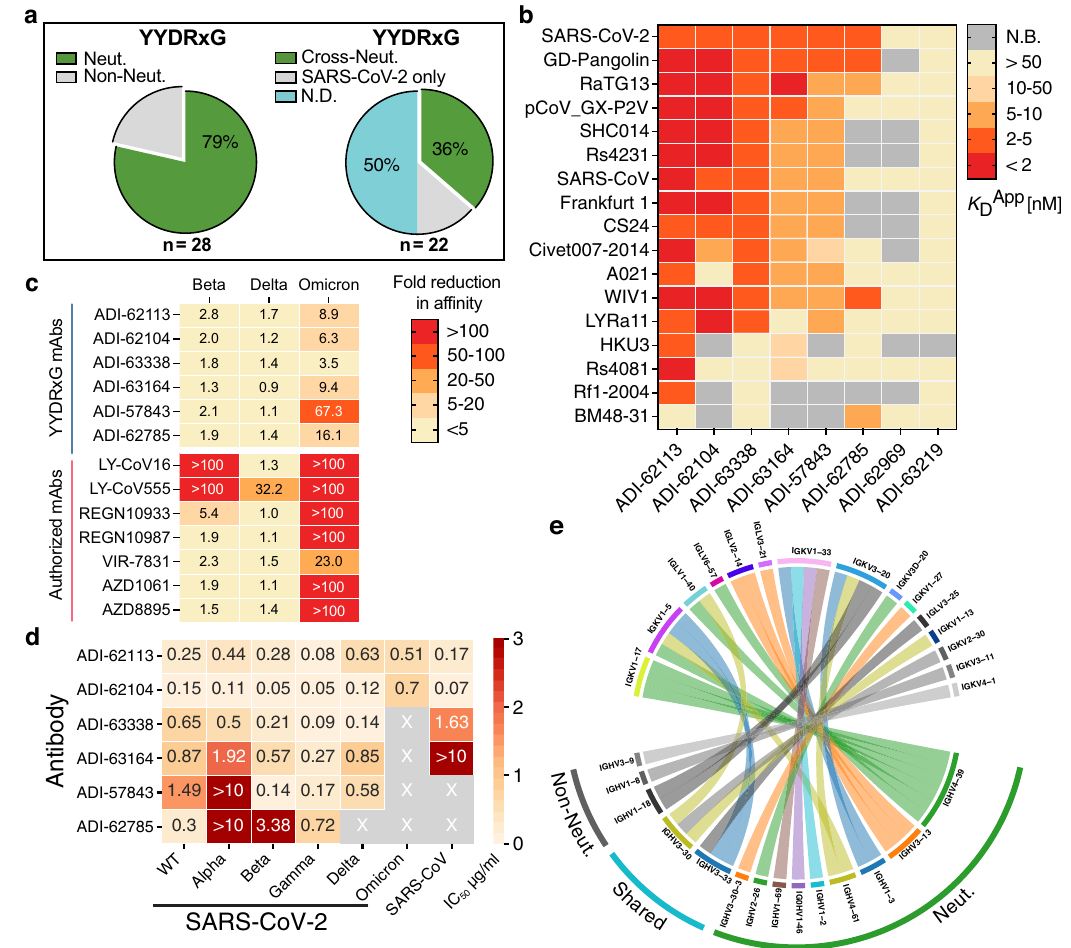
Fig. 5 YYDRxG antibodies are associated with broad neutralization against VOCs including Omicron. a Neutralization overview of YYDRxG antibodies against SARS-CoV-2. Antibodies with neutralization data available from this study or from previous publications are included in this analysis. Within 28 YYDRxG antibodies, 22 (79%) exhibit neutralization (Neut.) against SARS-CoV-2 (left). Among these 22 antibodies, 8 (36%) cross-neutralize (Cross- Neut.) SARS-CoV, while 3 (14%) do not (SARS-CoV-2 only); another 11 (50%) have not been tested against SARS-CoV (N.D.) (right). b Cross-reactivity of ADI antibodies with a YYDRxG motif across sarbecoviruses. ADI antibodies were titrated with sarbecovirus RBDs expressed on the yeast surface. Color bars indicate apparent binding af fi nity ( K D App ) as in the key. Red indicates strong binding, yellow indicates weak binding, and gray indicates no detectable binding (N.B.). Most antibodies are cross-reactive with many other sarbecovirus RBDs, except for ADI-63219 and ADI-62969. ADI-62113 showed the broadest spectrum of cross-reactivity to other sarbecoviruses. Titration curves used to determine binding af fi nities are shown in Supplementary Fig. 5. c YYDRxG antibodies generally preserve their binding to more challenging variants with strong escape mutations or increased transmissibility, such as Beta, Delta, and Omicron, while almost all antibodies under emergency use authorization do not. Kinetics for each antibody in binding to RBDs of the indicated SARS-CoV-2 variants were measured and compared to binding to the RBD of the wildtype ancestral virus. Fold reduction in af fi nity ( K D ) was plotted with red indicating substantial loss of binding (>100-fold reduction) and yellow indicating no signi fi cant change (<5-fold reduction). Titration curves used to determine binding af fi nities are shown in Supplementary Fig. 6. d ADI antibodies neutralize SARS-CoV-2, VOCs and SARS-CoV. Neutralization was tested using a pseudovirus assay system. Neutralization potency, i.e., IC 50 , for each antibody against corresponding viruses are shown on a heatmap with wheat indicating potent neutralization. X indicates weak to no neutralization activity. ADI-63219 and ADI-62969 showed no neutralization against SARS- CoV-2 and are not included in this heatmap. Titration curves used to determine neutralization potency are shown in Supplementary Fig. 7. e Distinct combinations of heavy and light variable genes used by neutralizing and non-neutralizing antibodies. Circos plot showing combinations of heavy and light chain variable genes in each encoded antibody. Colored ribbons represent variable genes encoding neutralizing antibodies (Neut.) while gray indicate non- neutralizing antibodies (Non-Neut.). IGHV3-30, IGHV3-33 , and IGKV3-20 were found in both neutralizing and non-neutralizing antibodies. YYDRxG antibodies against SARS-CoV-2 with neutralization data available are included in this analysis ( n = 28). Antibody names and CDR H3 sequences of these antibodies are included in Supplementary Table